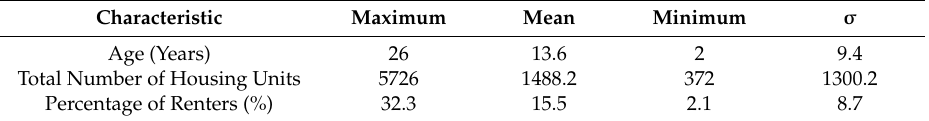
Table 1. Profile of the sampled private housing communities ( n = 17).